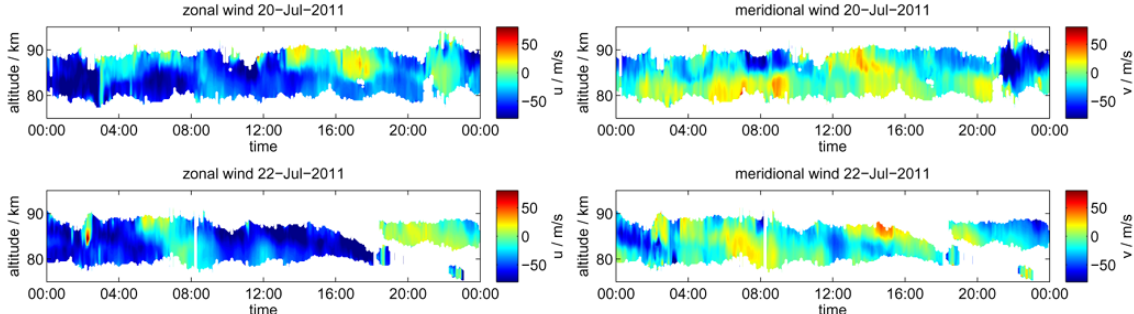
Fig. 5. Observed zonal and meridional wind from MAARSY measurements using PMSE as tracer for 20 and 22 July 2011. The time is given in UTC.